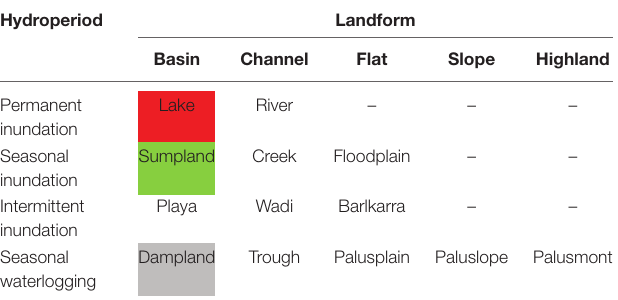
TABLE 1 | Classification of Swan Coastal Plain based on their morphology, hydrology, stratigraphy, and geomorphic units.